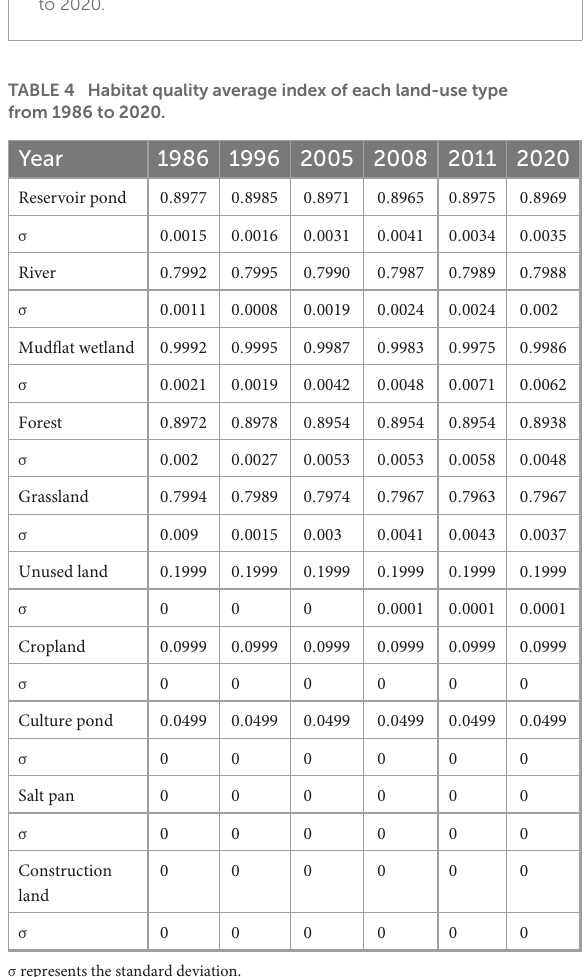
FIGURE7 Habitat quality average index (right axis) and the percentage of area with different levels of habitat quality (left axis) from 1986 to 2020.